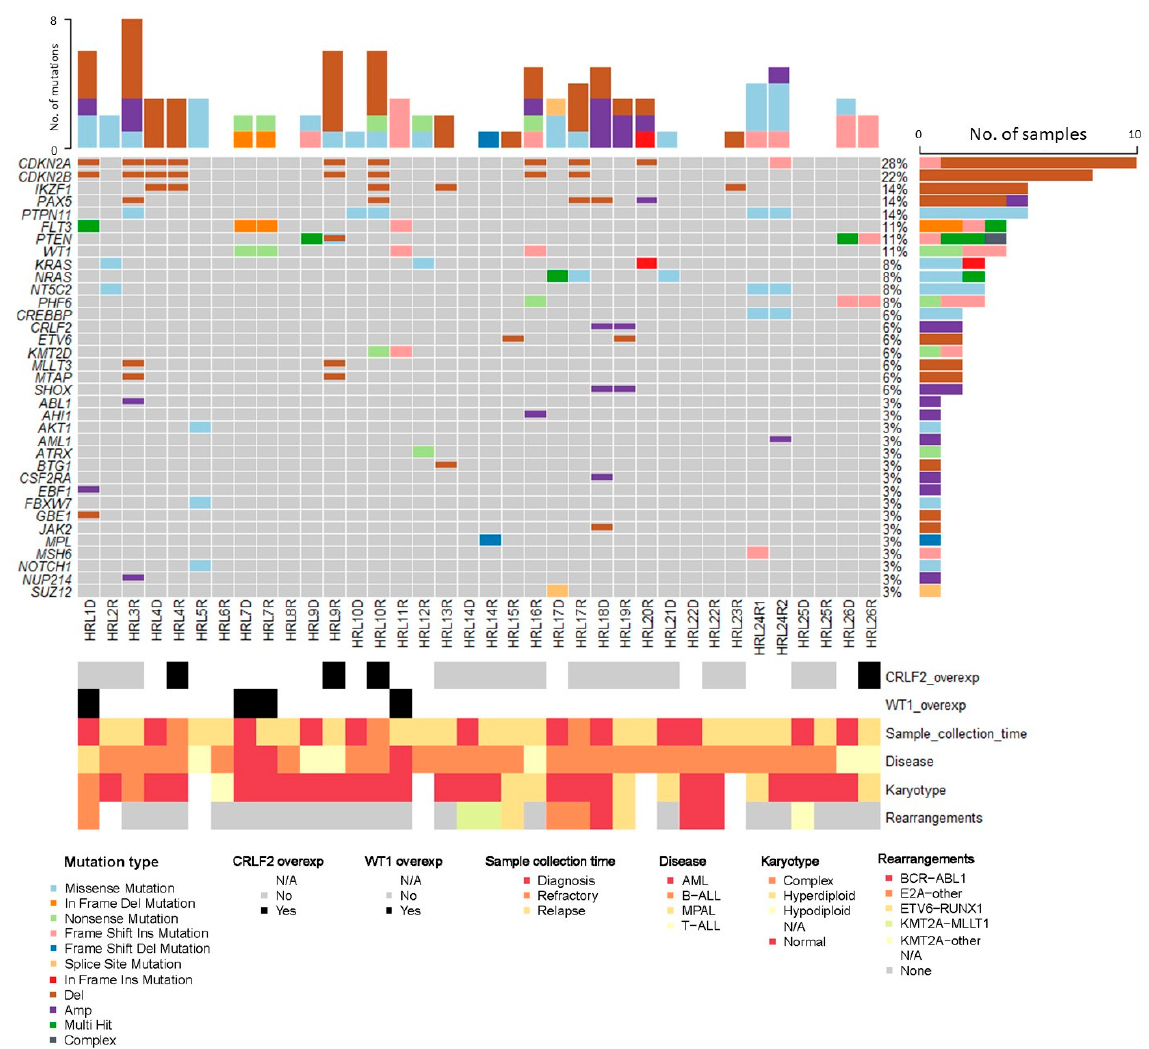
Figure 2. Advanced molecular characterisation of the analysed samples.